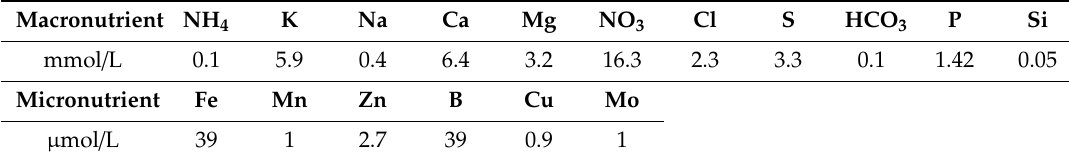
Table A2. University of British Columbia horticulture greenhouse stock fertilizer solution.